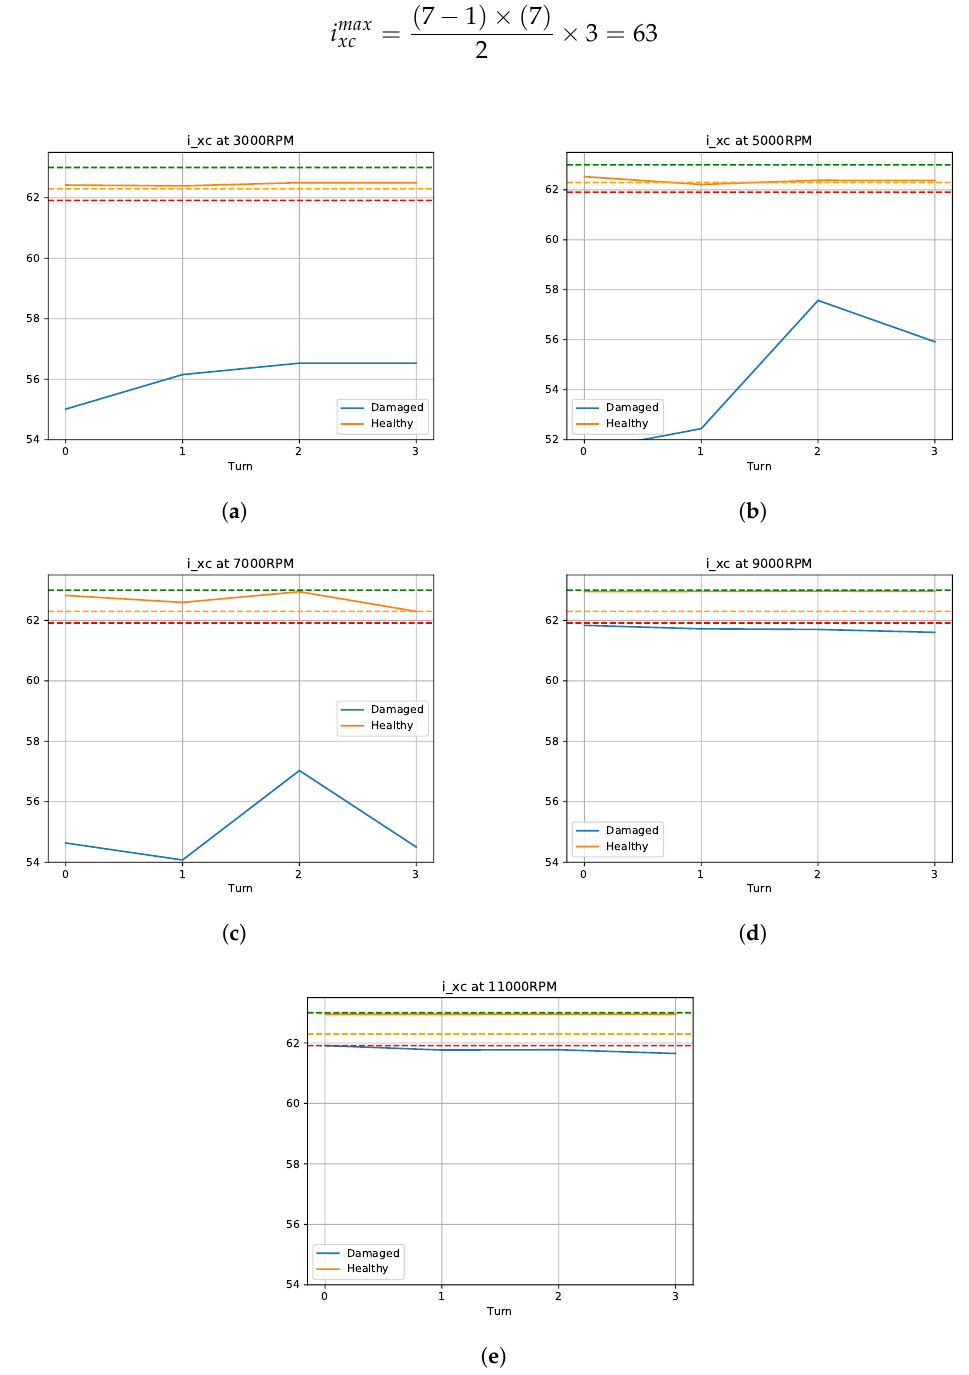
Figure 15. i xc indicator at various speed for healthy and faulty motors. ( a ) i xc —3000RPM; ( b ) i xc —5000RPM; ( c ) i xc —7000RPM; ( d ) i xc —9000RPM; ( e ) i xc